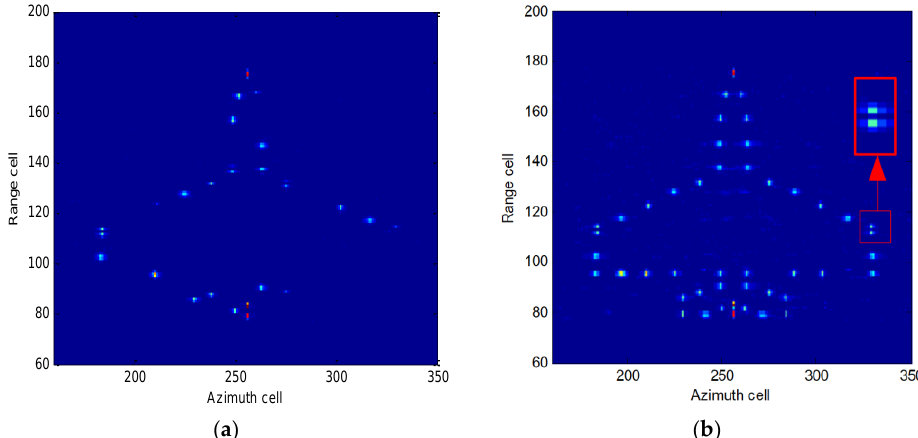
Figure 12. Azimuth compression via ICPF-FRFT: ( a ) without the CLEAN technique and ( b ) with the CLEAN technique.